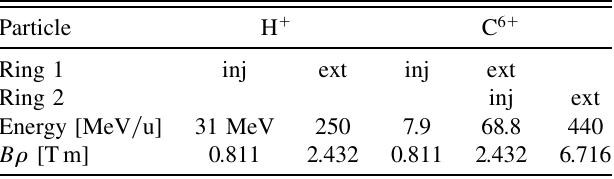
TABLE II. Particle kinetic energies and magnetic rigidities for the two-ring complex, where ‘‘inj’’ is the injection energy to the ring and ‘‘ext’’ is the highest extraction energy for each ring. Note that the second ring could accelerate protons to 1.2 GeV for